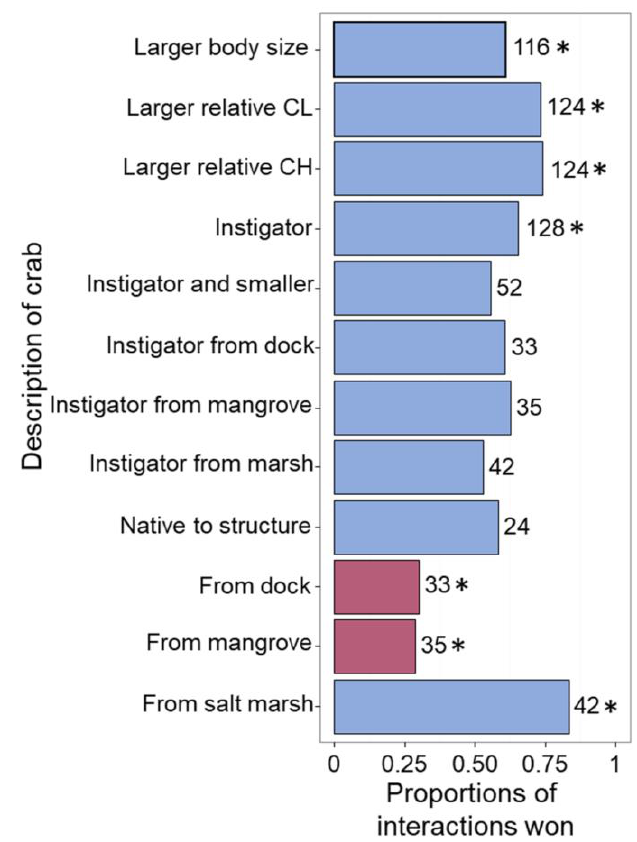
Figure 2. Proportion of interactions won by a variety of categories of competitor. Numbers represent the number of interactions examined while asterisks (*) represent significant effects ( α = 0.05). Blue bars represent proportions above 0.5 while red bars represent those below 0.5.